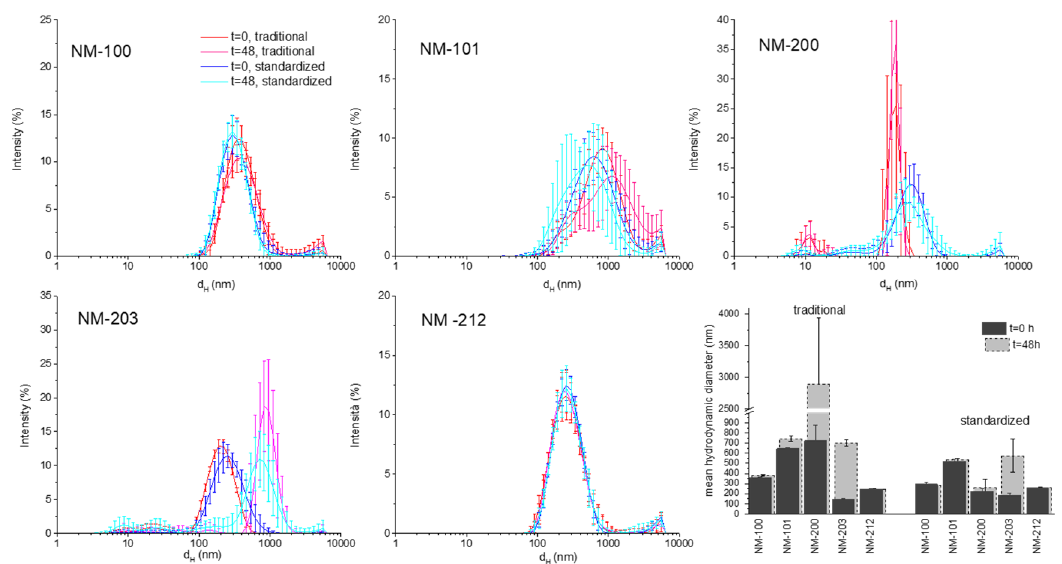
Figure 5. DLS analysis of the NM in RPMI at 100 µg/mL at t = 0 and t = 48 h. The panels represent for each sample the comparison between the suspensions prepared by the traditional protocol and those prepared by the standardized protocol. In the last panel, the mean Z D ± SD are reported. Data are the mean of 30 measurements.